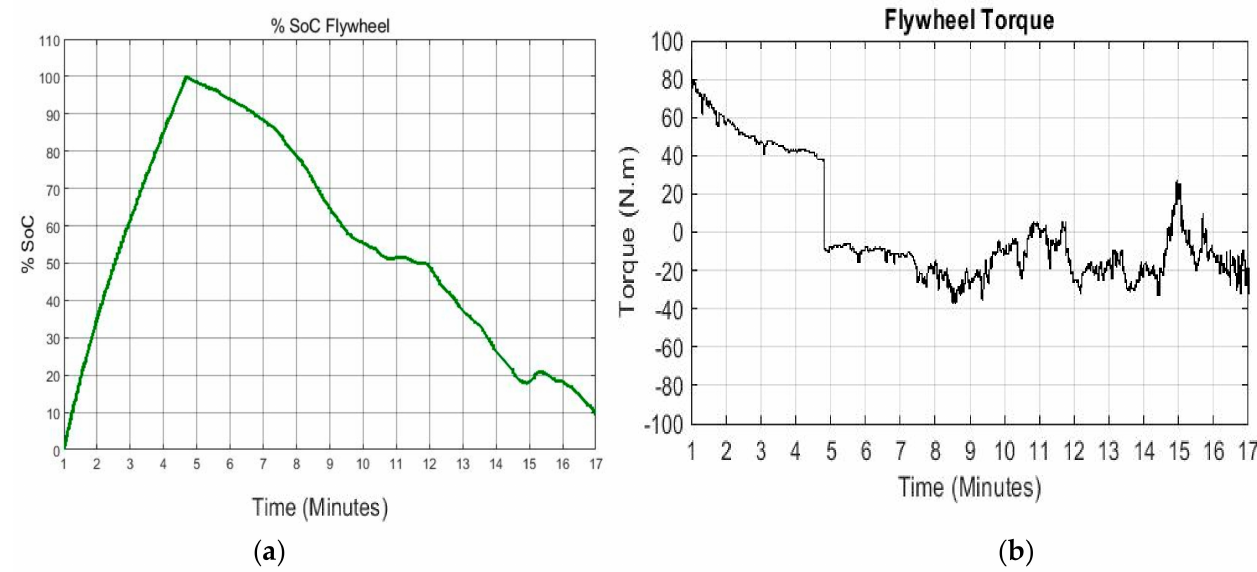
Figure 26. ( a ) %SoC of flywheel; ( b ) Flywheel torque.